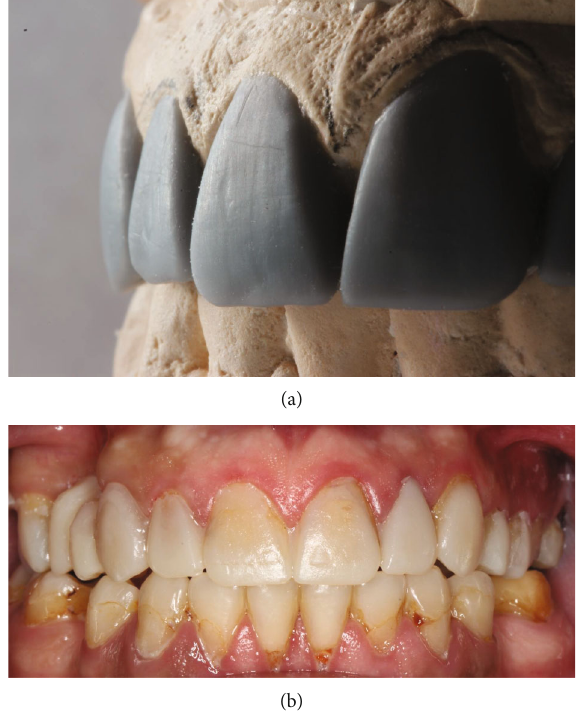
Figure 2: (a) Diagnostic wax-up illustrating the desired corrected tooth relationship. (b) Diagnostic mock-up